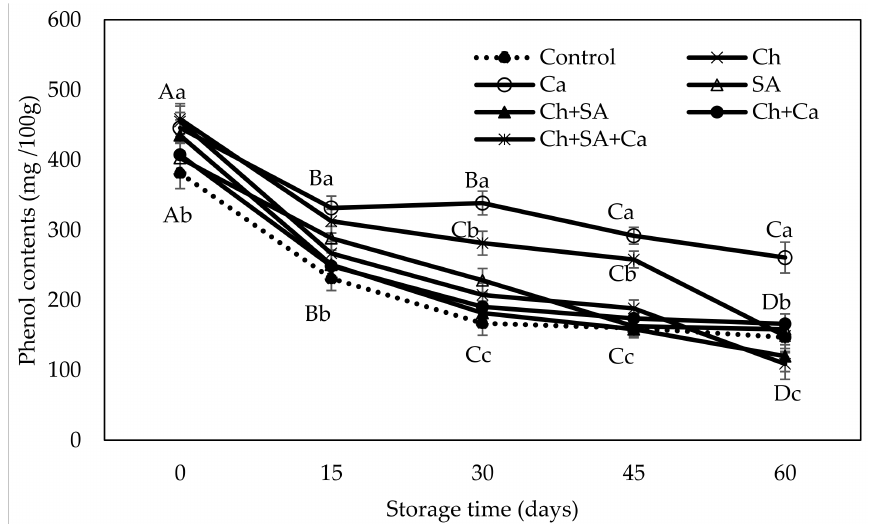
Figure 4. Effects of preharvest application of natural elicitors on the total phenol content of “Barhi” fruit during cold storage for two months; values are the mean (n = 3) ± SE. The LSD test at p ≤ 0.05 was used to compare the means between treatments. Means with the same letter(s) between treatments within storage time intervals (small letter) and at different time intervals (capital letter) are not significantly different. Ch: chitosan; SA: salicylic acid; Ca: calcium